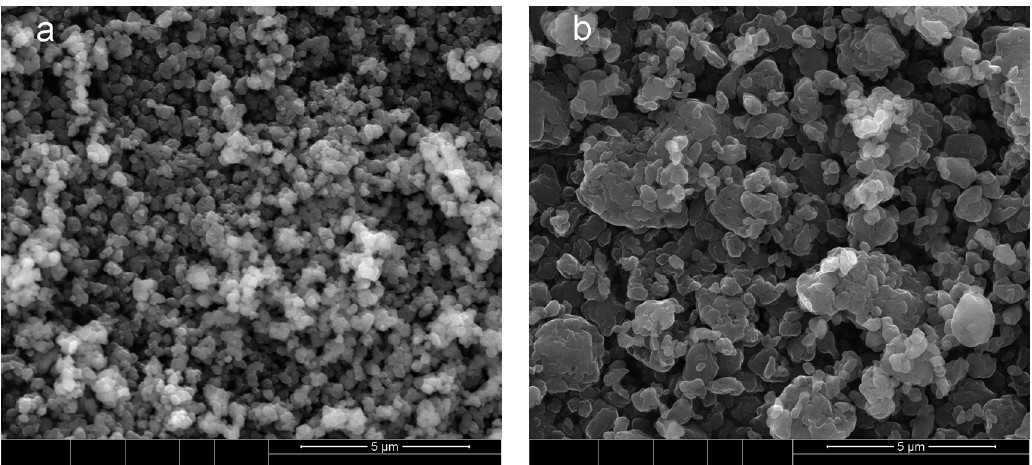
Figure 1. SEM of ( a ) mesoporous MnO 2 and ( b ) PANI/ mesoporous MnO 2 .